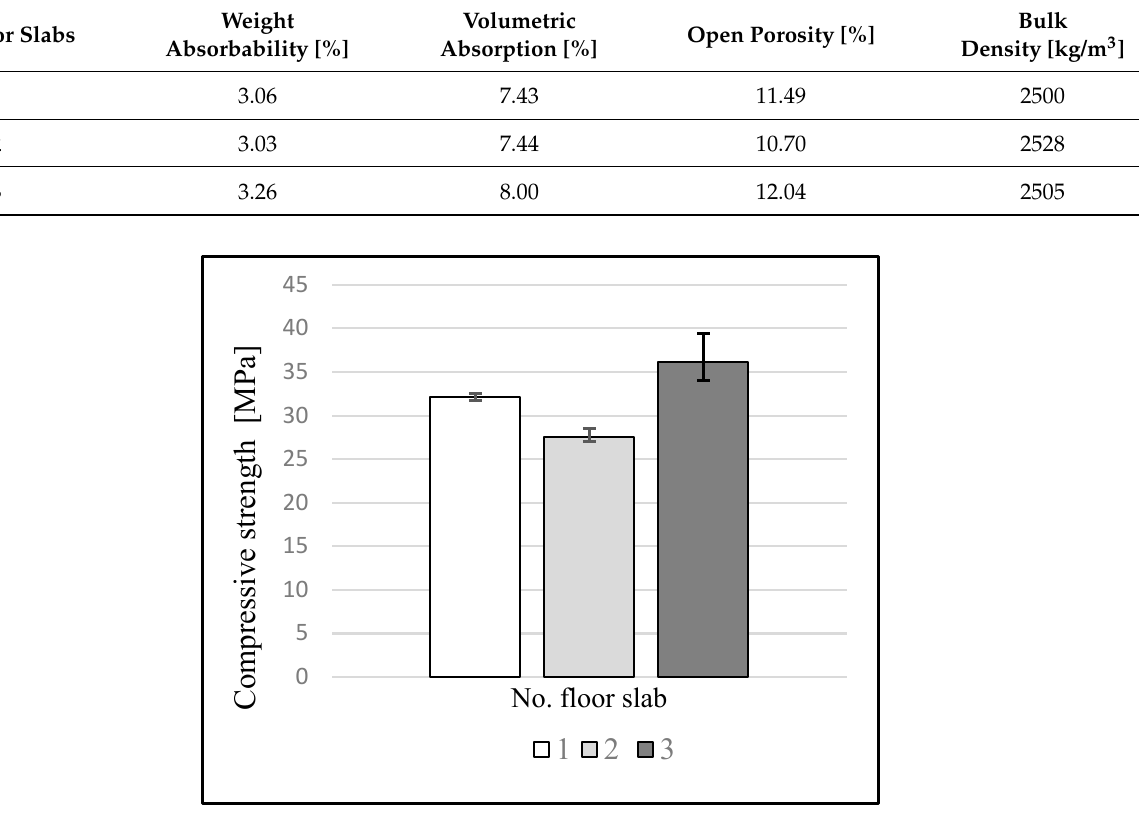
Figure 13. Dependence of the compressive strength on the weight absorption. The weight absorption of the concrete samples from floor slabs 1 and 2 was similar, and ranged from 2.8 to 3.2%, but the samples had different compressive strengths. The concrete samples from floor 3 had the highest compressive strength and weight absorp- tion among all the samples.